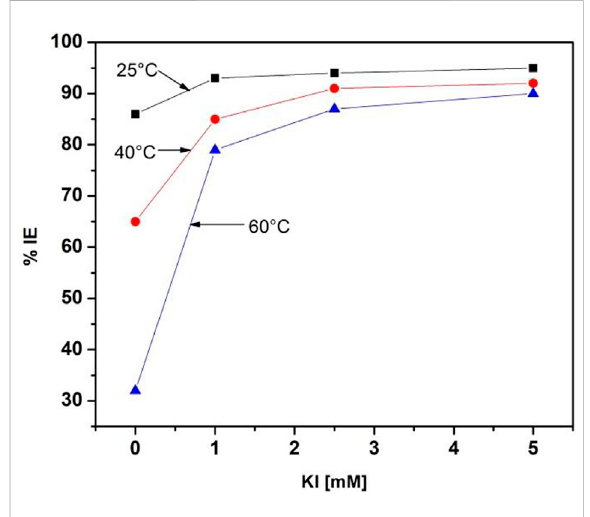
FIGURE 6 M. sativa inhibition ef fi ciency comparison at 500 ppm with different KI concentrations and different temperatures.